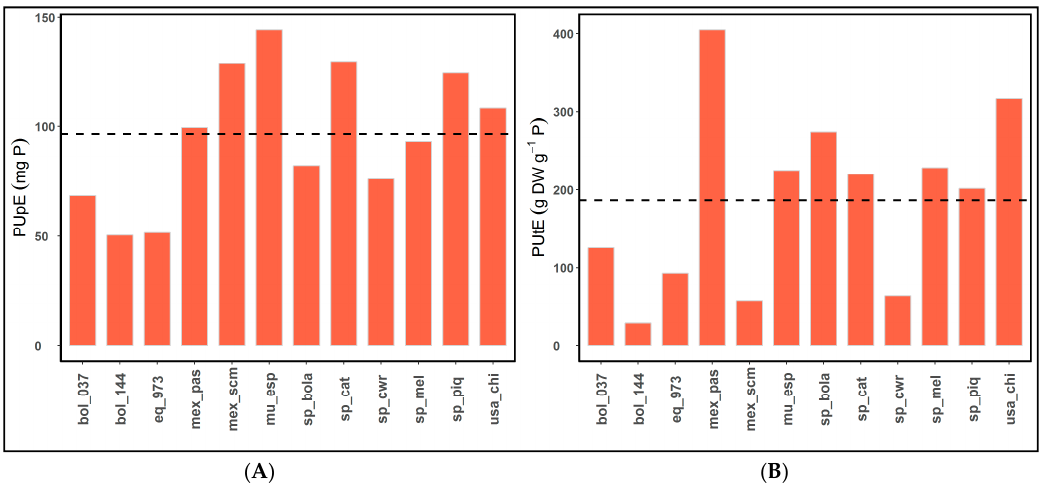
Figure 2. ( A ) Average PUpE (P Uptake Efficiency) and PUtE (P Utilisation Efficiency) values for the 12 accessions ( n = 4) studied in Trial 1. ( B ) The black dashed line represents the average value for the whole collection for both PUpE (96.56 mg P) and PUtE (186.55 g DW g − 1 P) parameters.